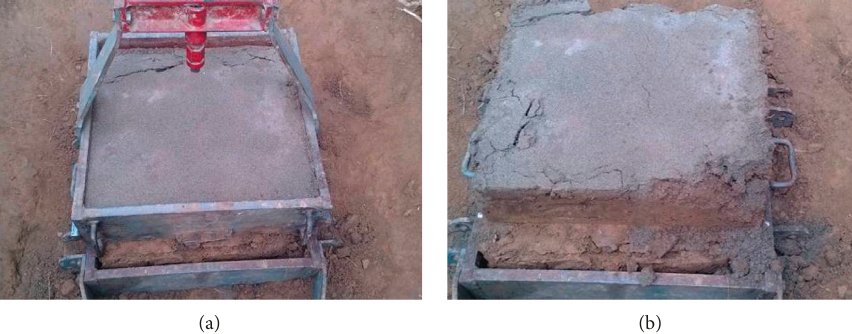
Figure 5: Damaged samples of in situ direct shear tests.